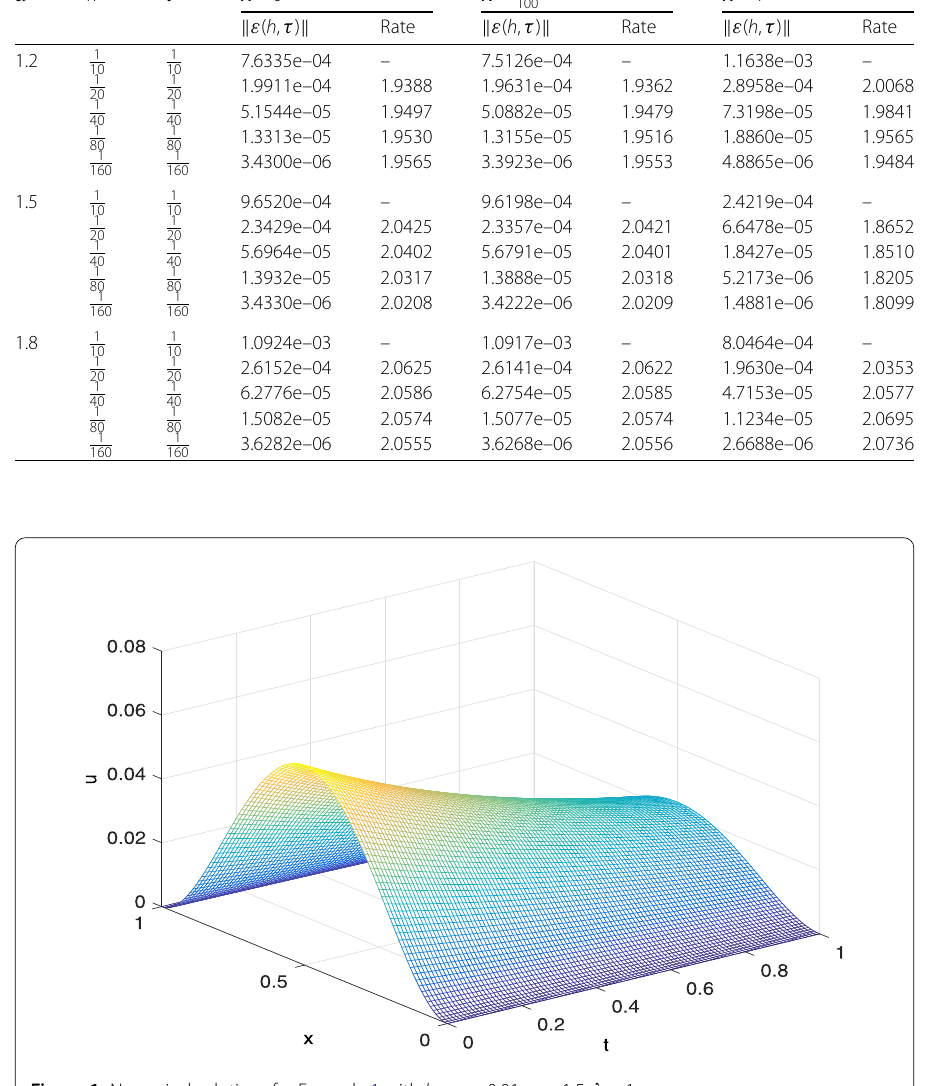
Figure 1 Numerical solutions for Example 1 with h = τ = 0.01, α = 1.5, λ = 1